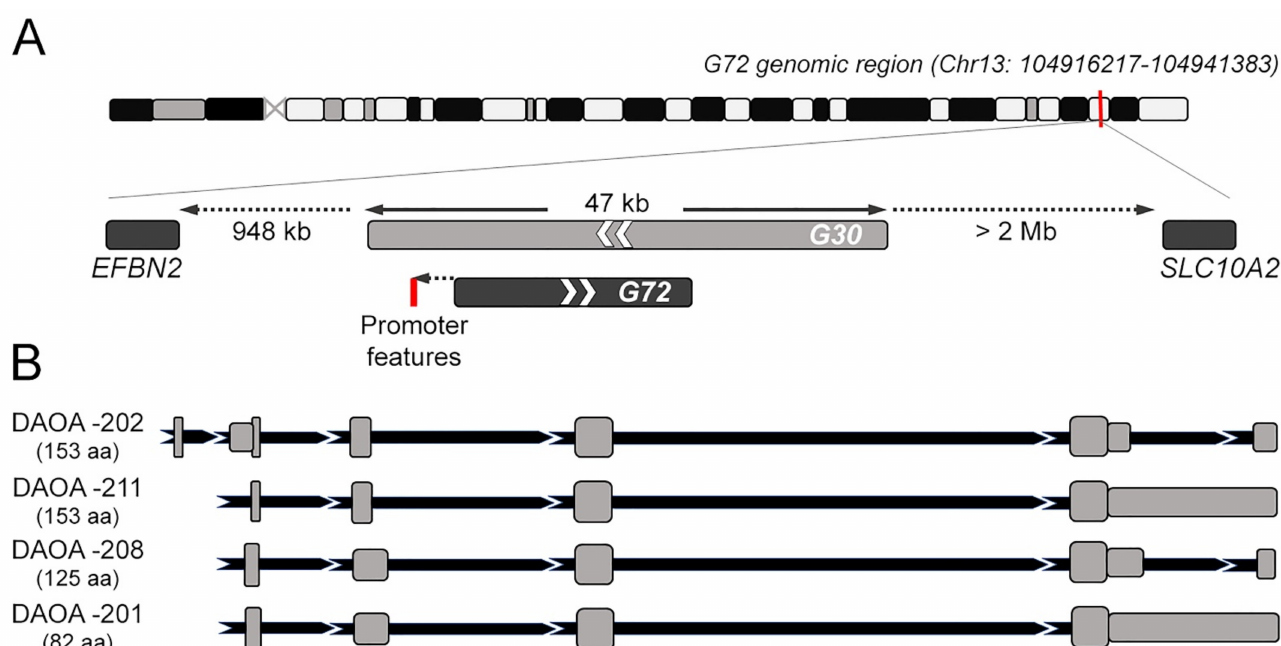
Figure 1. Genomic context and alternative primary transcript variants for G72 gene. ( A ) Representa- tion of G72 genomic context on chromosome 13. The overlapping G30 gene, as well as neighboring genes are shown in the detail. ( B ) Structure of the G72 alternative transcripts coding for pLG72 protein isoforms as reported in the UCSC Genome Browser and Ensembl. Exons are drawn as grey boxes, intronic sequences are reported in black. DAOA-202, ENST00000375936.9; DAOA-211, ENST00000618629.1; DAOA-208, ENST00000595812.2; DAOA-201,